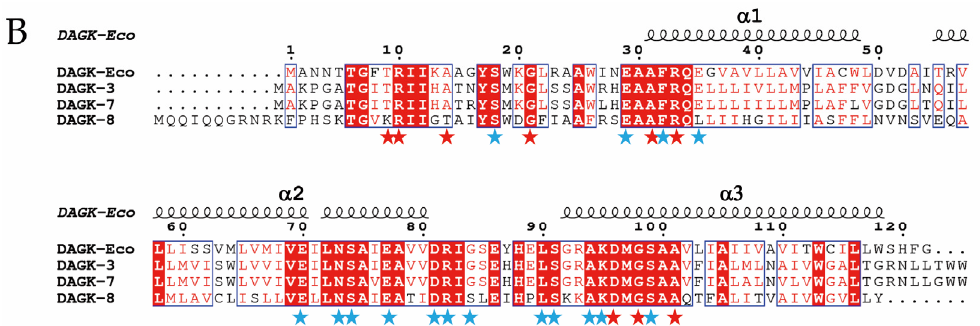
Figure 8. Structural determinants of hPAP2 and DAGK proteins. Multiple sequence alignments were performed by Clustal X 2.0 and emulated by EsPript 3.0. ( A ) Secondary structure elements of PgpB (4PX7) are shown above aligned PAP2 proteins, whose sequences are as follows: PgpB, NP_415362; LpxT, CQR81684; YbjG, WP_061361528; PAP2-1, WP_095885326; PAP2-6, OOS23616.1; PAP2-7, AUR80100. All sequences shown are from E. coli except for PAP2-6 ( Moraxella pluranimalium ) and PAP2-7 ( Klebsiella pneumoniae ). The three motifs involved in substrate binding are shown, with the catalytic triad His C2 –Asp C3 –His C3 indicated by red (conserved) or blue (non-conserved) triangles [7]. ( B ) Secondary structure elements of DAGK (2KDC) are shown above aligned proteins, whose sequences are as follows: DAGK-Eco, NP_418466.1; DAGK-3, WP_039026395.1; DAGK-7, AUR80099; DAGK-8, AVX52228. All sequences shown are from E. coli except for DAGK-7 and DAGK-8 ( K. pneumoniae ). Key residues for protein functioning that were previously determined are indicated by blue (role in activity) or red (role in folding) triangles [5].